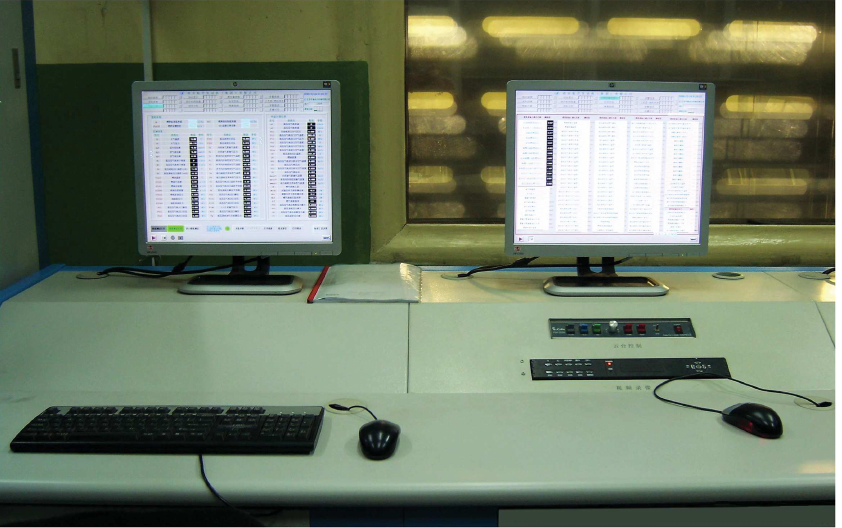
Fig 10. HIL system: monitors and gas generator and rotor system